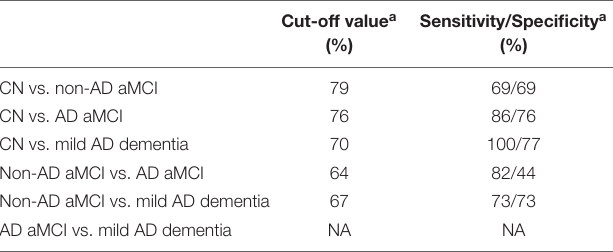
TABLE 2 | Sensitivity and specificity for the relevant cut-off values in the spatial pattern separation task.